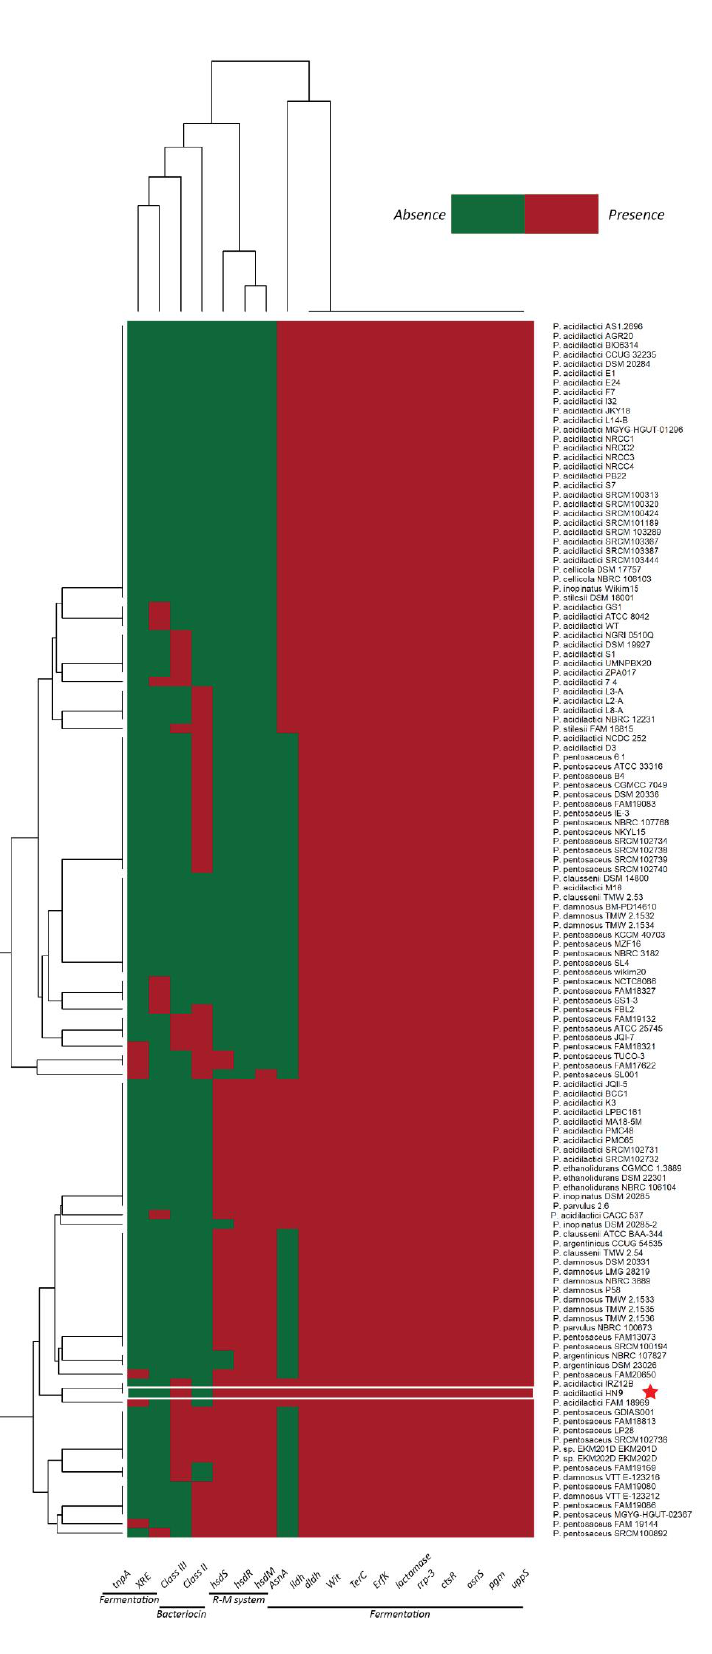
Figure 8. Gene presence-absence heatmap of fermentation related genes. 19 genes were selected to compare the ability in fermentation of Pediococcus 129 strains. Red color represents the presence of the gene and green color indicates the absence of the gene in the genome. The red star indicates the location of P. acidilactici HN9